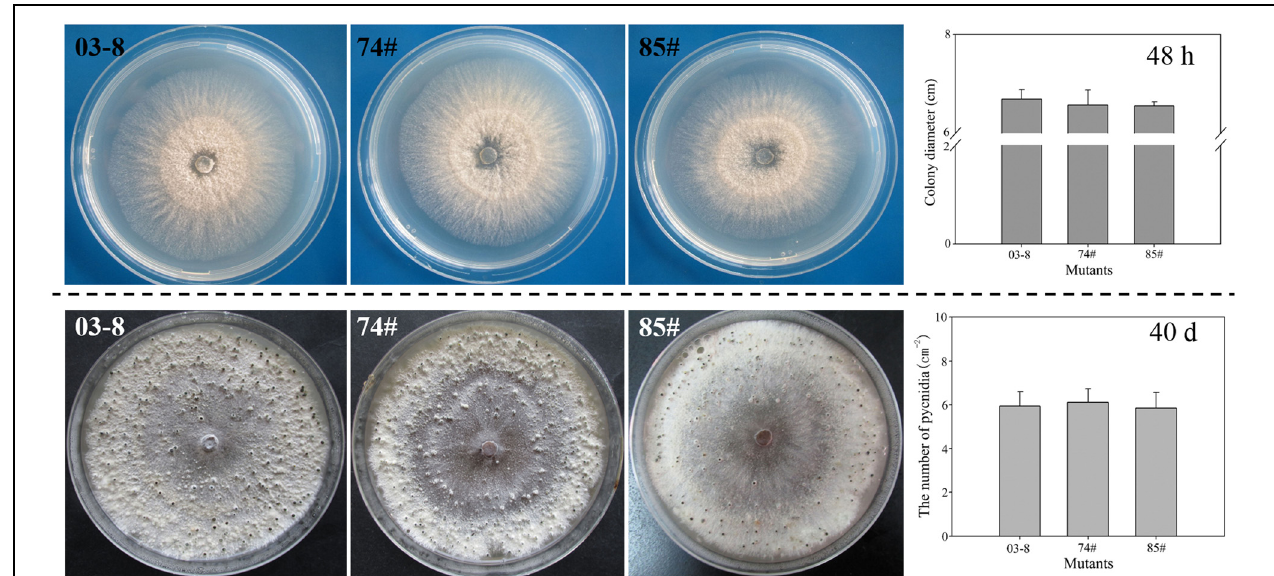
FIGURE 5 | Impact of VmEp1 deletion on vegetative growth and conidiation. Wild-type (03–8), and VmEp1 deletion mutants (74#) and (85#) were grown on PDA for 48 h or 40 days at 25 ◦ C. Colony diameter and number of mature pycnidia were counted. Bars indicate standard deviation of the mean of 30 individual dishes. The experiment was repeated three times.